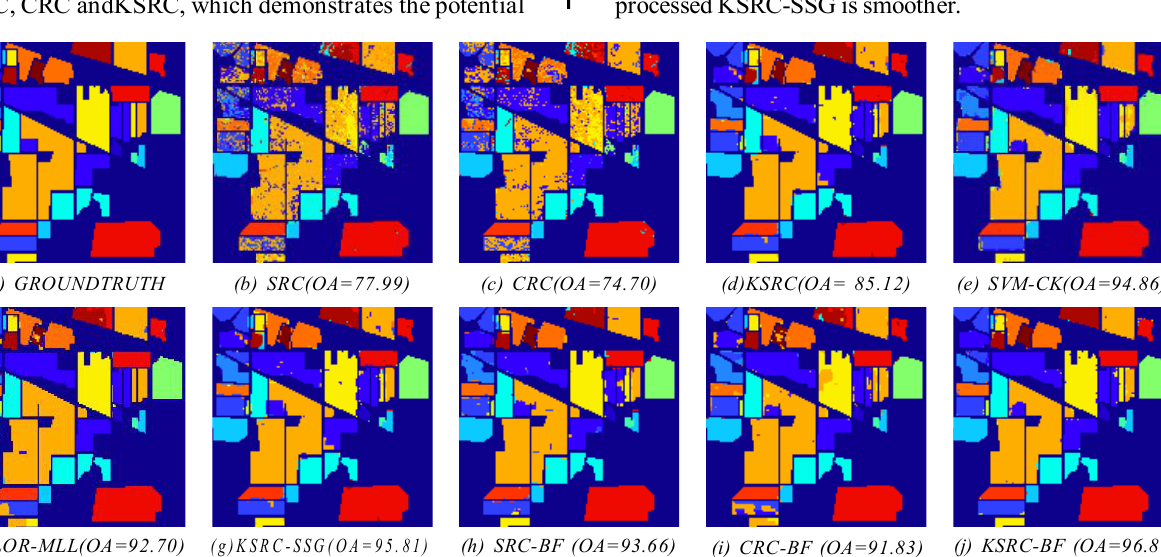
FIG. 2. INDIAN PINES IMAGE: REFERENCE DATA AND VISUAL CLASSIFICATION RESULTS